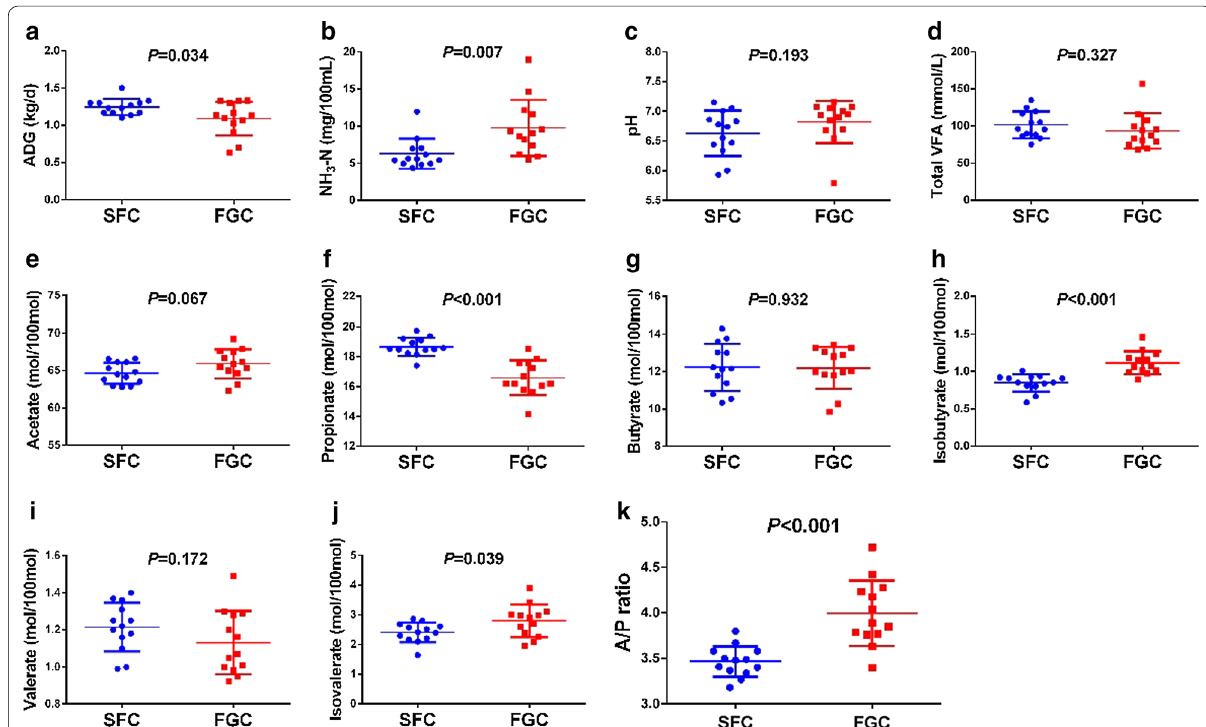
Fig. 1 Effects of different corn processed methods (steam flaked corn (SFC) and finely ground corn (FGC)) on rumen fermentation characteristics and growth performance of dairy heifers. a average daily gain; b NH 3 -N in rumen fluid; c pH in rumen fluid; d total VFA; e acetate; f propionate; g butyrate; h isobutyrate; i valerate; j isovalerate; k acetate-to-propionate ratio